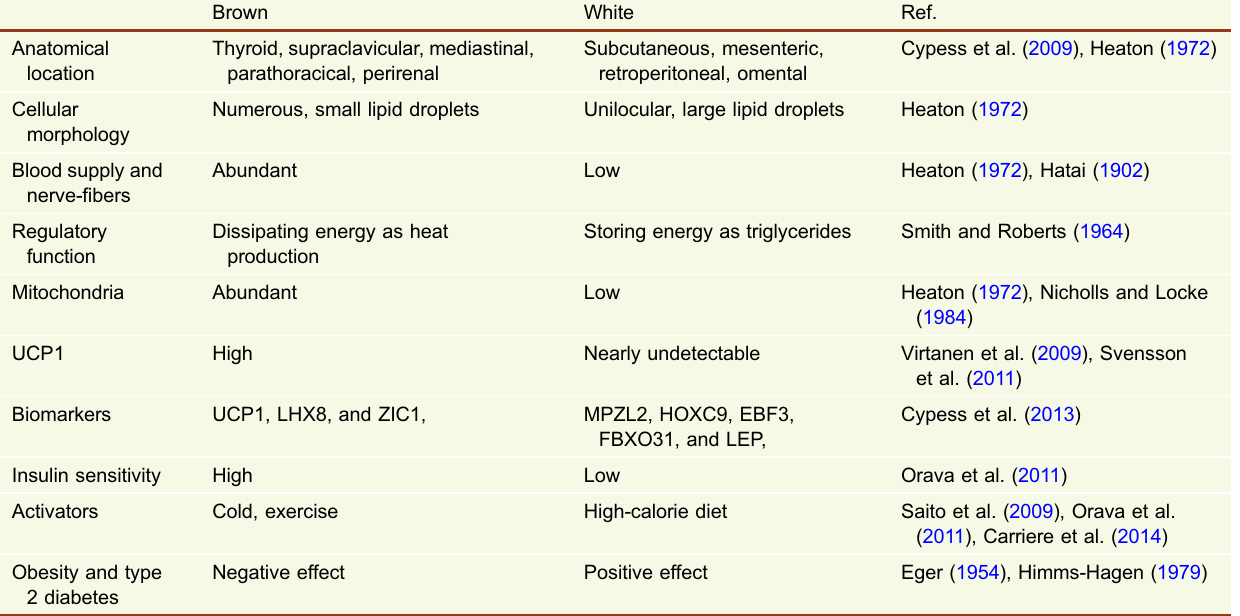
Table 1. Differences between brown and white